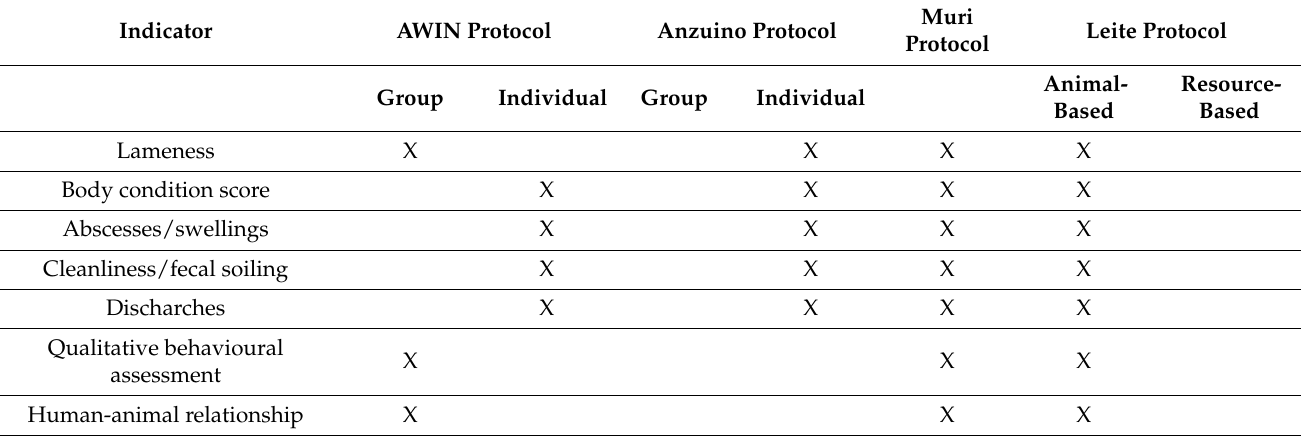
Table 1. List of goat welfare indicators included in each of the presented assessment protocols. Indicators included in a protocol are marked by X. For the AWIN protocol and the Anzuino protocol., the inclusion in the group level and individual level is stated. For the Leite protocol, animal-based and resource-based indicators are listed separately. Resource-based indicators are listed for completeness but are not discussed in detail. Similar indicators, such as udder asymmetry, udder abnormalities, or udder pathologies are summarised as single row, although they may be evaluated as separate indicators within a